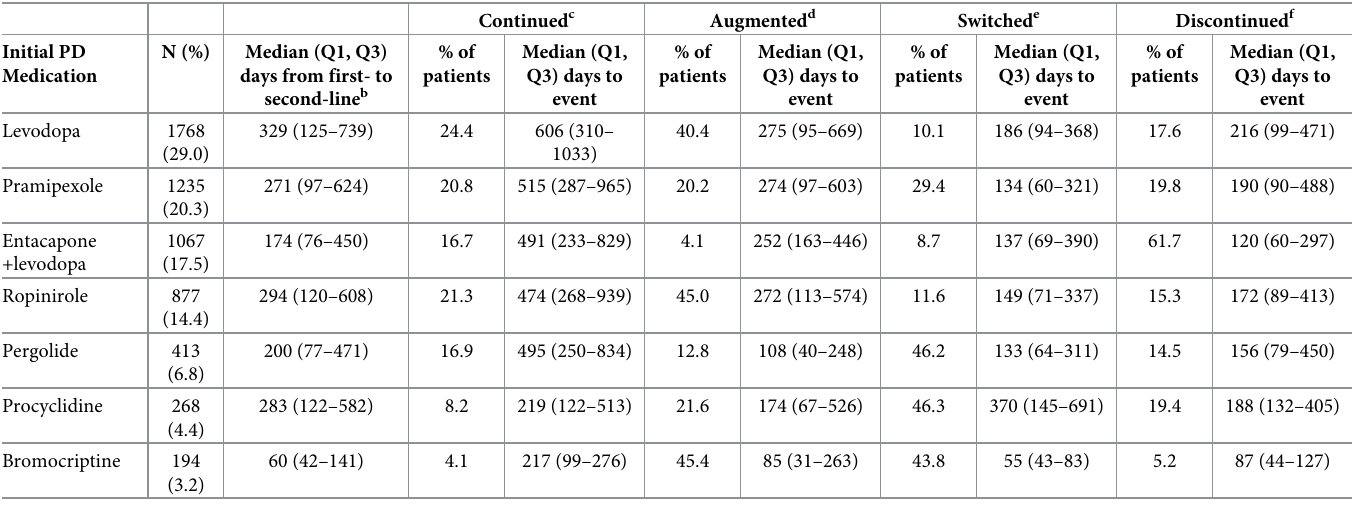
Table 3. The most common first-line PD medication for UK patients in the CPRD database a